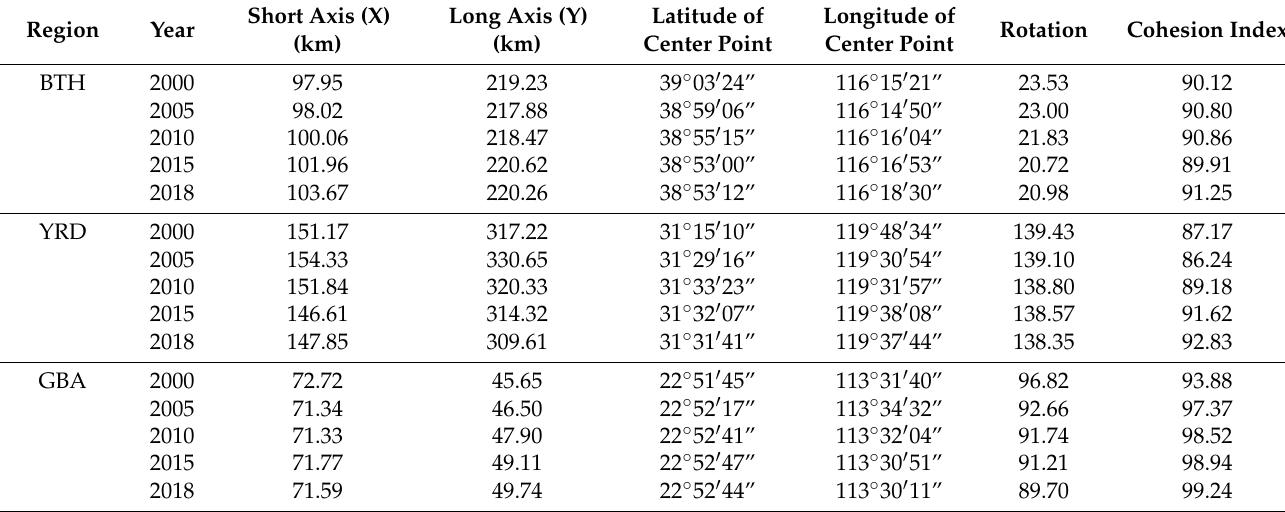
Table 3. The parameters from the directional distribution analysis using standard deviation ellipses and cohesion indexes of urban areas in three urban agglomerations for 2000, 2005, 2010, 2015, and 2018.